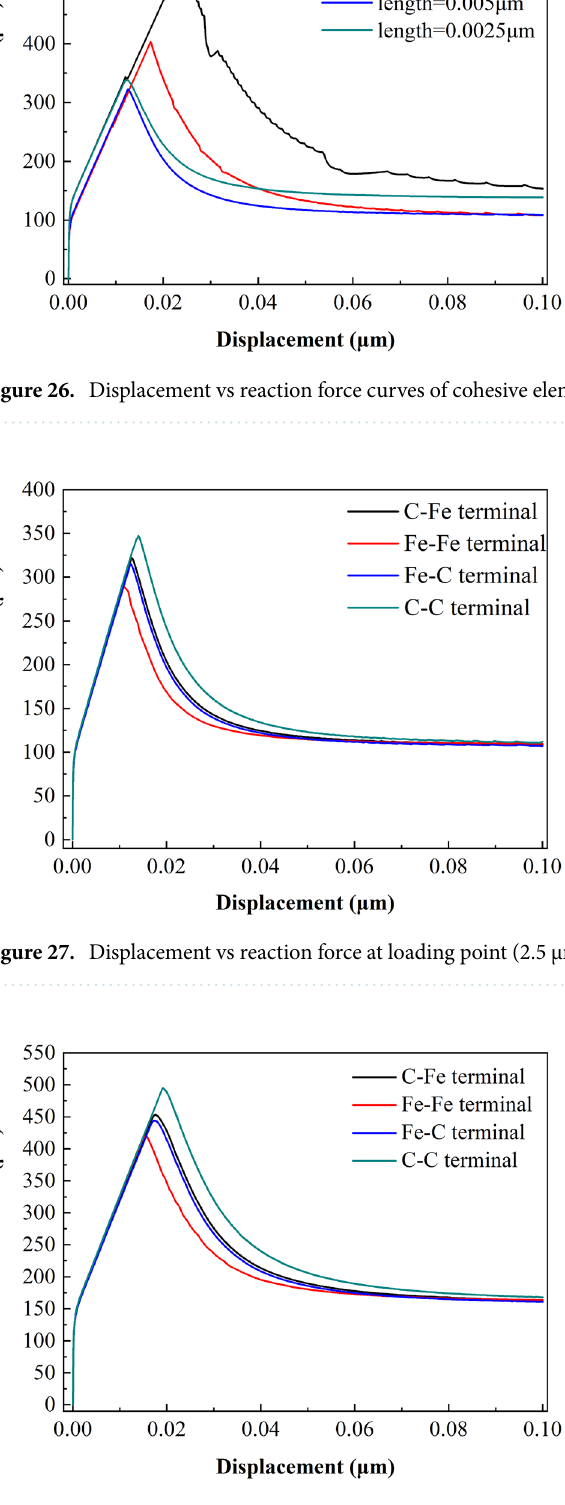
Figure 28. Displacement vs reaction force at loading point (5 μm × 4.8